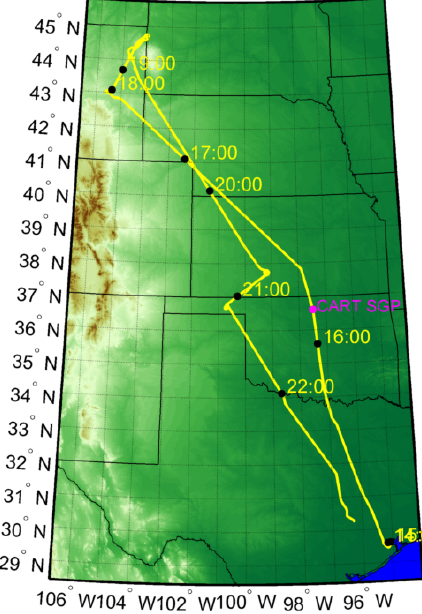
Figure 12. Ground tracks for the 19 August 2013 research flight of the SEAC4RS field campaign, in the southern USA. CART SGP stands for the Cloud and Radiation Testbed (CART) Southern Great Plains (SGP) site.